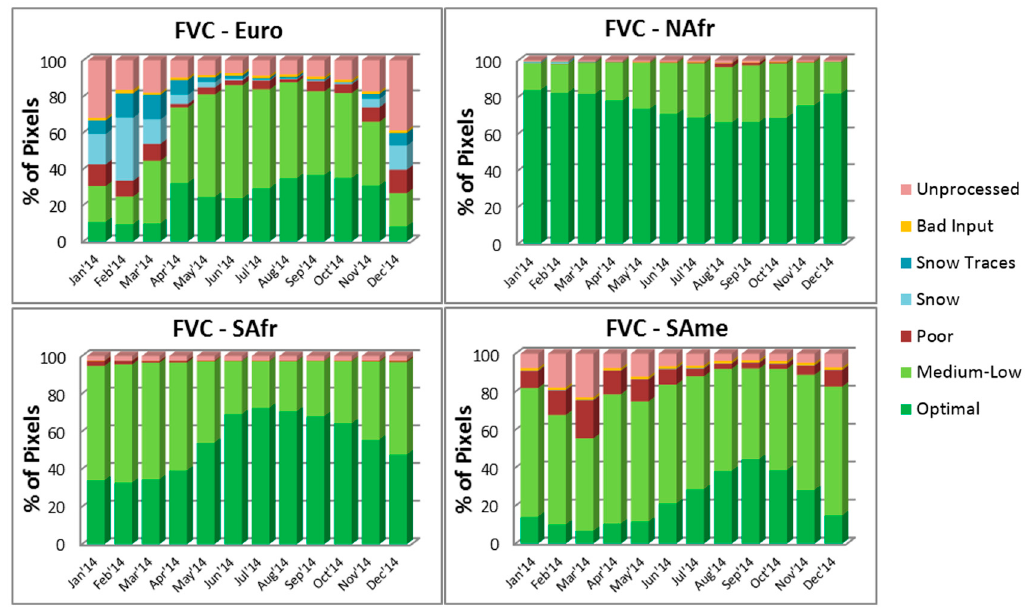
Figure 8. Monthly fraction of valid pixels for daily MSG FVC product during the entire 2014 year over the four SEVIRI geographical areas.